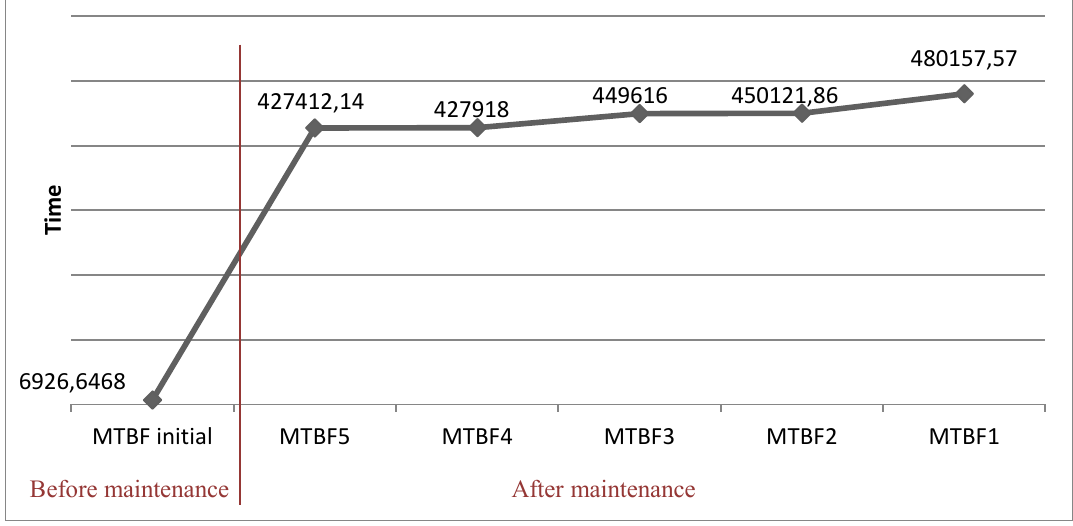
Figure 5. Dependability